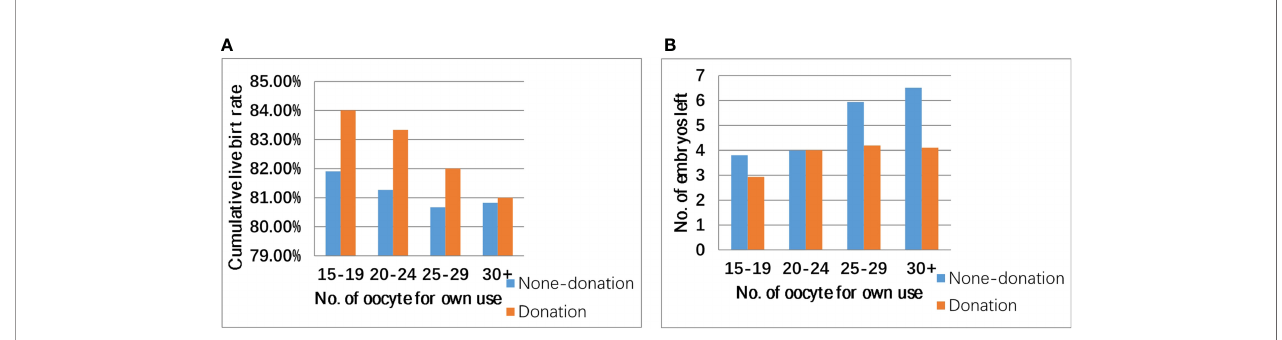
FIGURE 1 | Cumulative live birth rate (A) , number of supernumerary embryo (B) , and number of oocytes retrieved in patients eligible for oocyte donation (oocyte